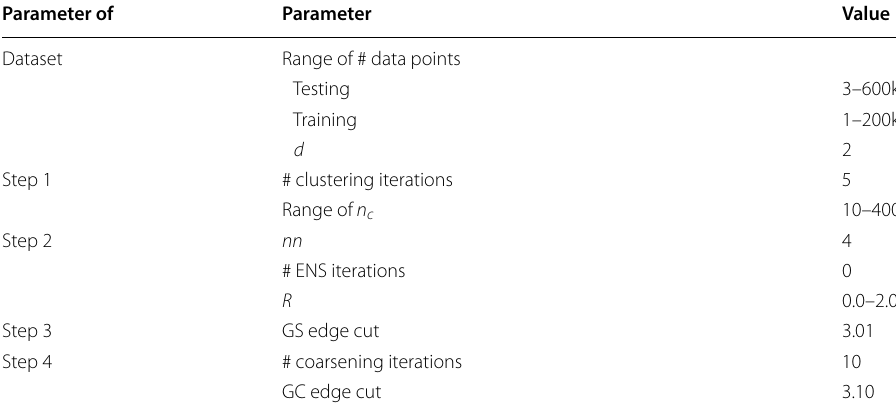
Table 5 Dataset I and II along with steps parameters Parameter of